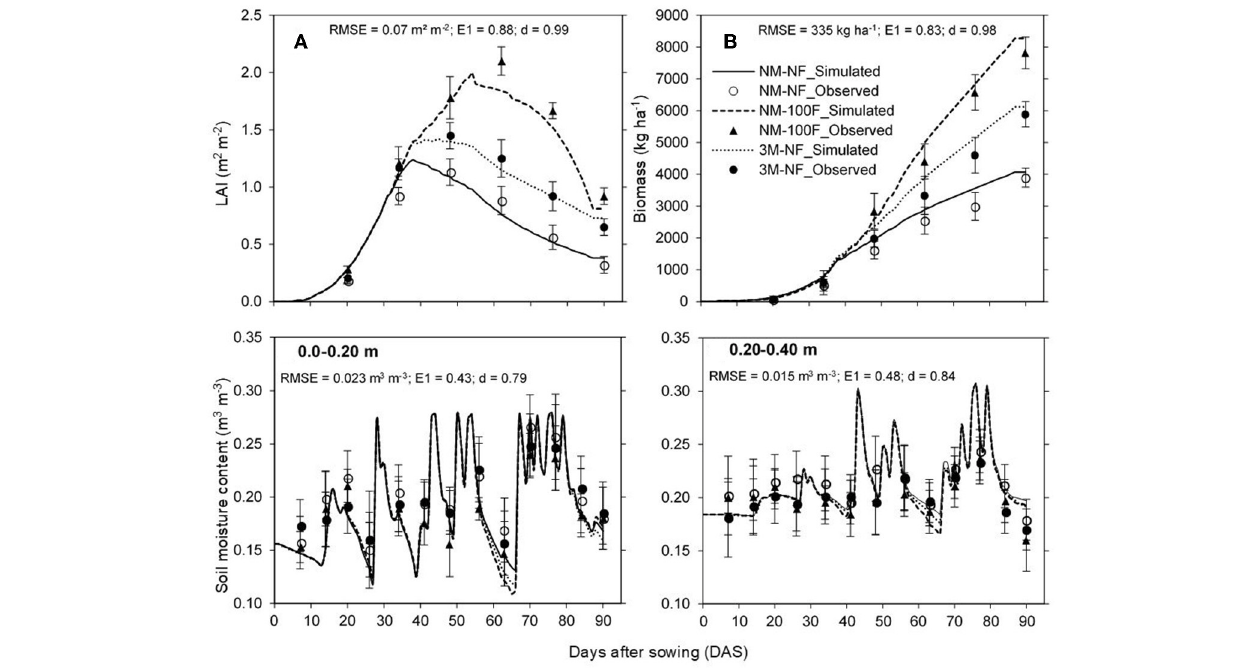
FIGURE 1 | Comparison between observed and simulated time-series of maize LAI (Upper panel, A ), above ground biomass (Upper panel, B ) and soil water content in the 0.0–0.20m and 0.20–0.40m layers (Lower panel) during model calibration in 2014. NM, no manure; NF, no fertilizer; 100F, 100% of the recommended